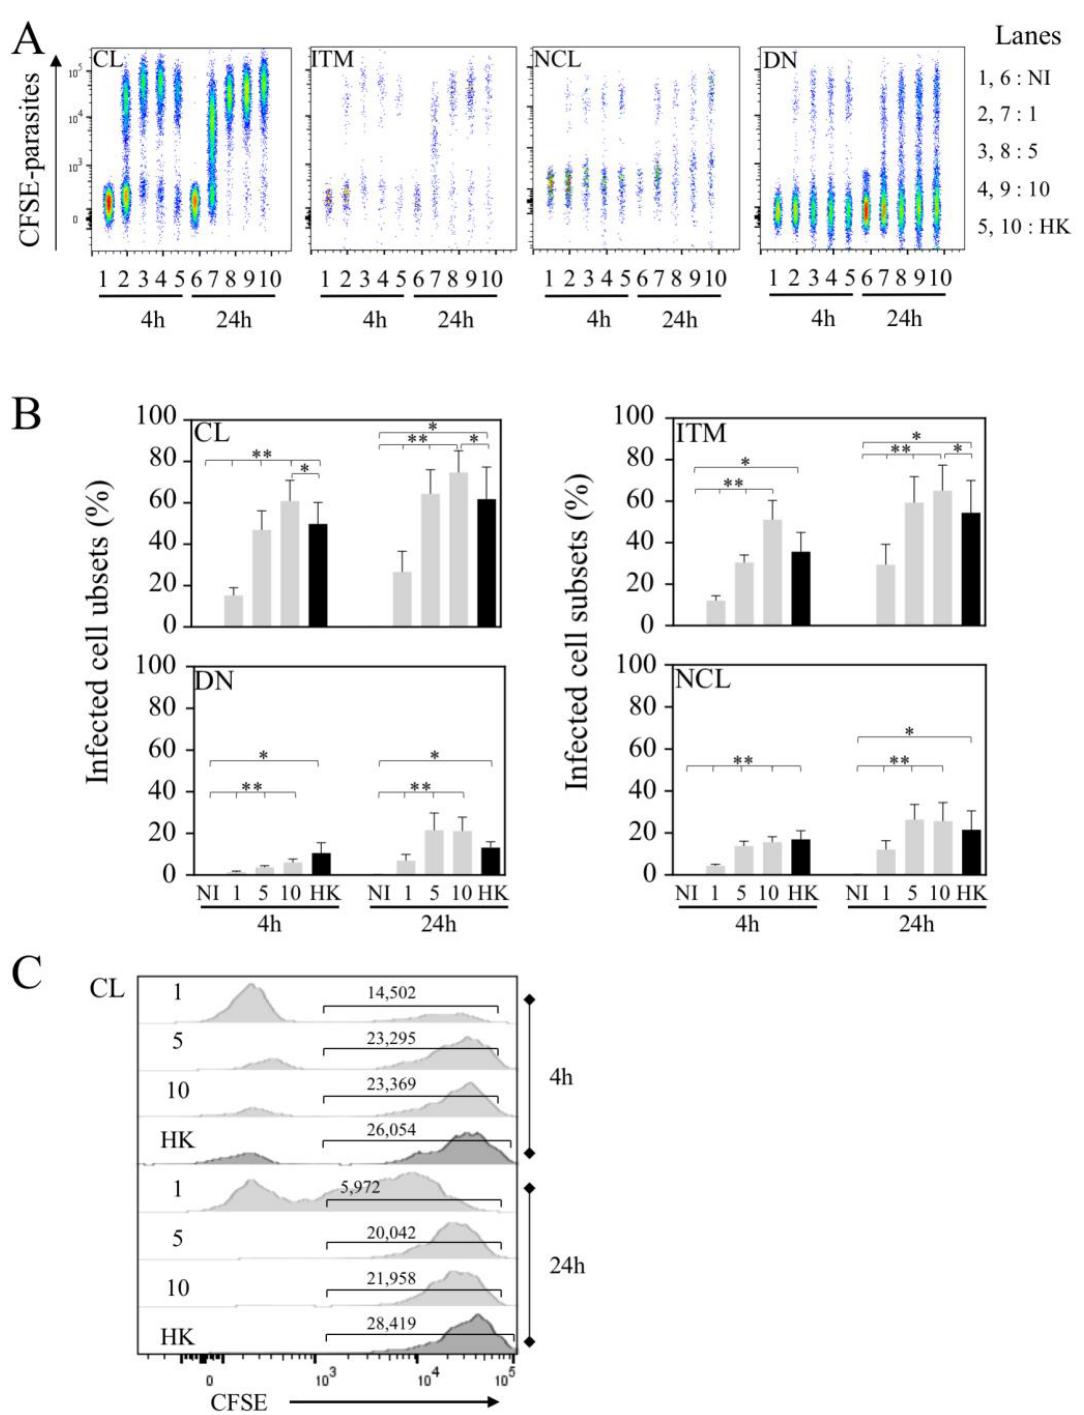
Figure 3. CL and ITM populations are preferentially infected by Leishmania infantum . ( A ) Flow cytometry of Li -infected cells. Representative concatenation of CFSE parasites in classical (CL), intermediate (ITM), non-classical (NCL) and double-negative (DN) monocytes. Whole blood was infected with 1.10 6 , 5.10 6 or 10.10 6 live (1, 5 and 10, respectively) and 10.10 6 HK parasites. Cells were analyzed 4 and 24 h post-infection. ( B ) Percentages of Li -infected cells in each subset. ( C ) Geometric mean of CFSE parasites in CL-infected monocytes. Statistical analyses were performed using Wilcoxon test (* p < 0.05, ** p < 0.01; n = 7).